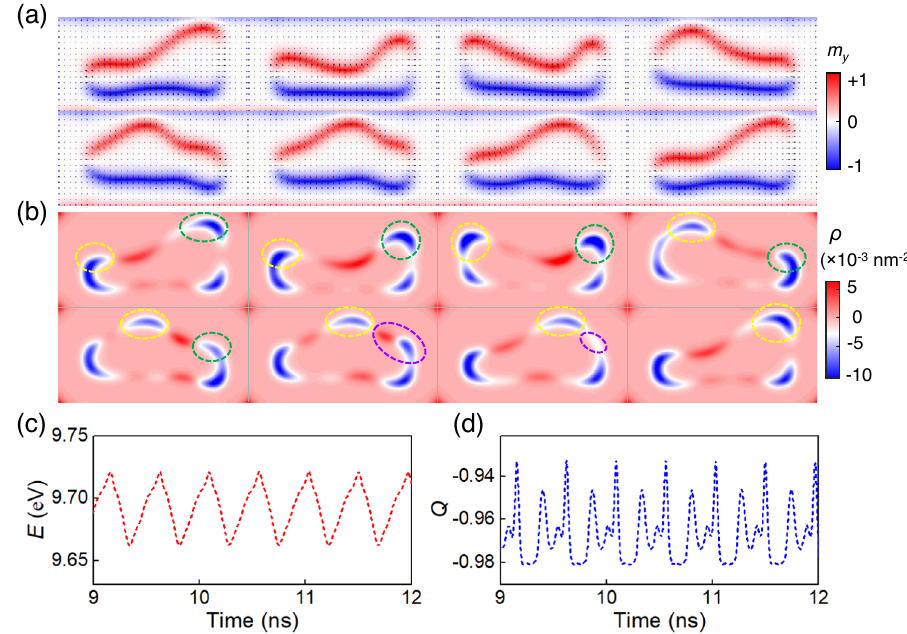
Fig. 3 Periodic deformation of an elongated skyrmion during the oscillation. Snapshots of a the magnetization and b the corresponding spatial distributions of the topological charge density at different simulation time in a period. The color bar in ( a ) represents the y component of the magnetization m y , while it describes the topological charge density ρ in ( b ). Variations of ( c ) the total energy E and ( d ) the net topological number Q during the